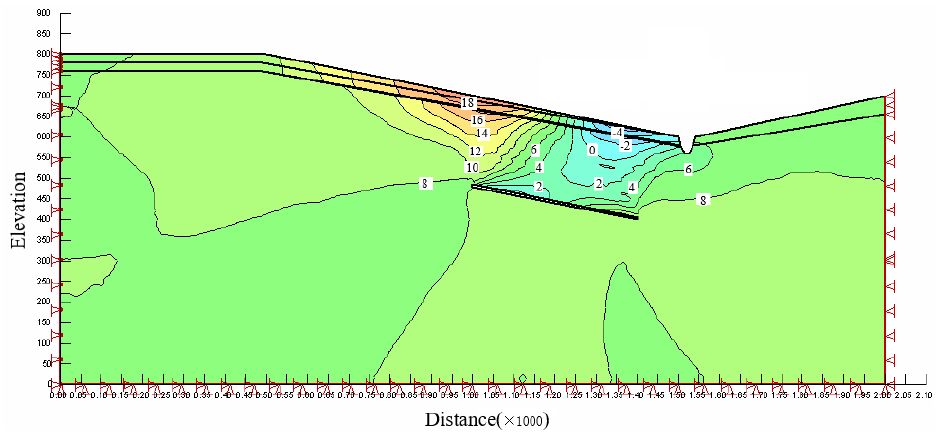
Figure 11. Displacement contour map of the slope in the X-direction before sliding.